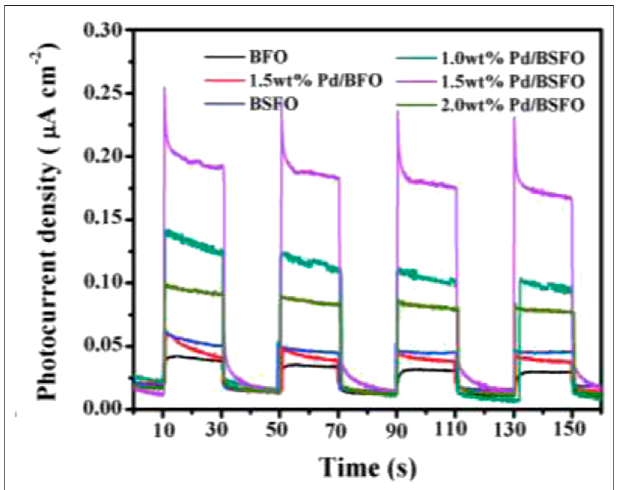
FIGURE 5 | RhB concentration varying with time through different degradation processes. PC, photocatalytic process; EC,